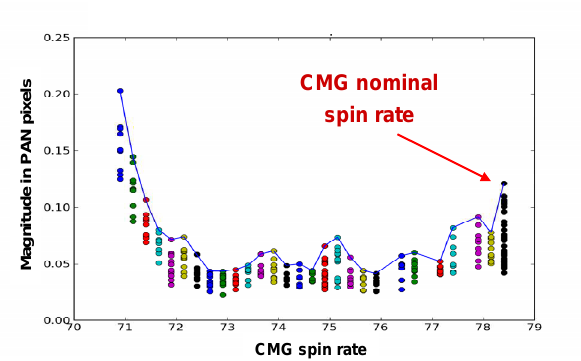
Figure 14 : maximum micro-vibrations magnitude vs CMG spin rate